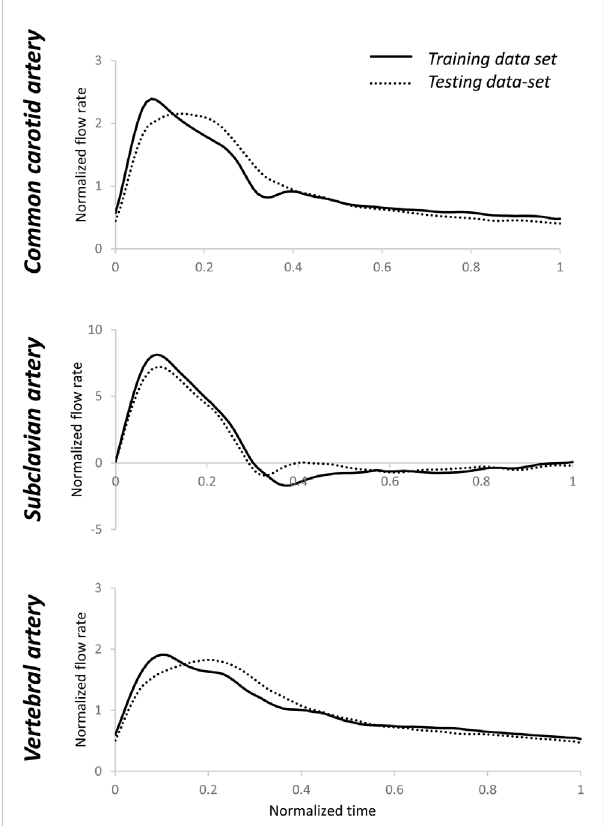
FIGURE 6 Averagesofnormalizedtesting fl owratewaveformsforcommon carotid, subclavian, and vertebral arteries. The averages of the training fl ow rate waveforms that were used in section 2.3 are also shown. There were visible differences between the training and testing fl ow rate waveforms. Normalization was performed post-simulation for comparison purposes.